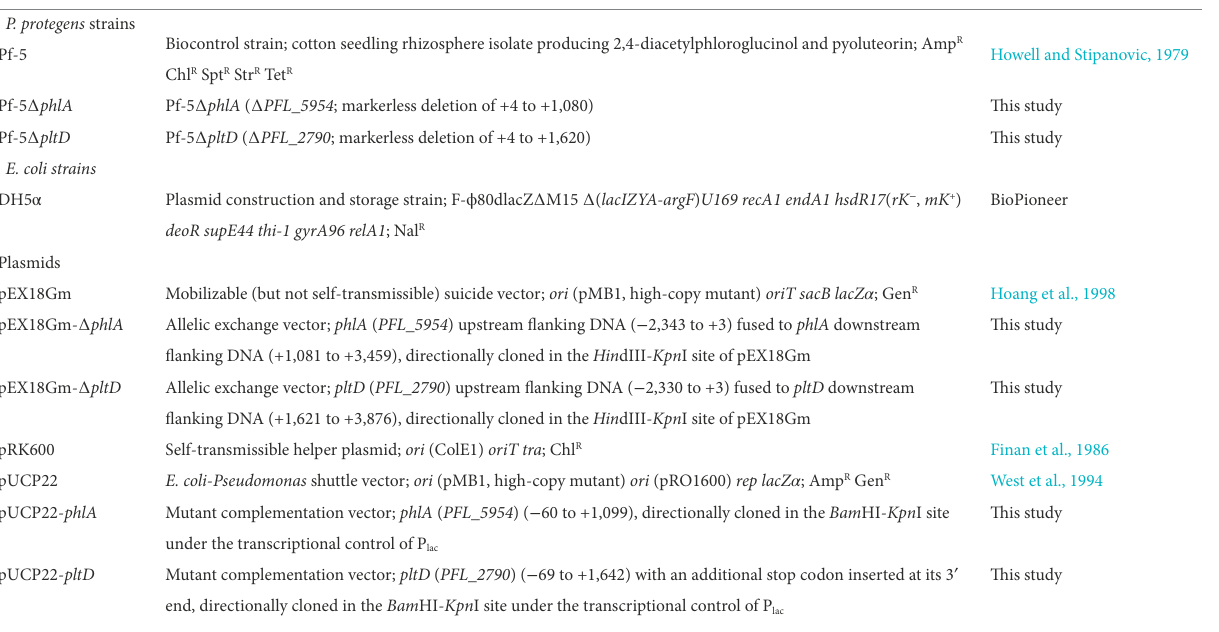
TABLE 1 Bacterial strains and